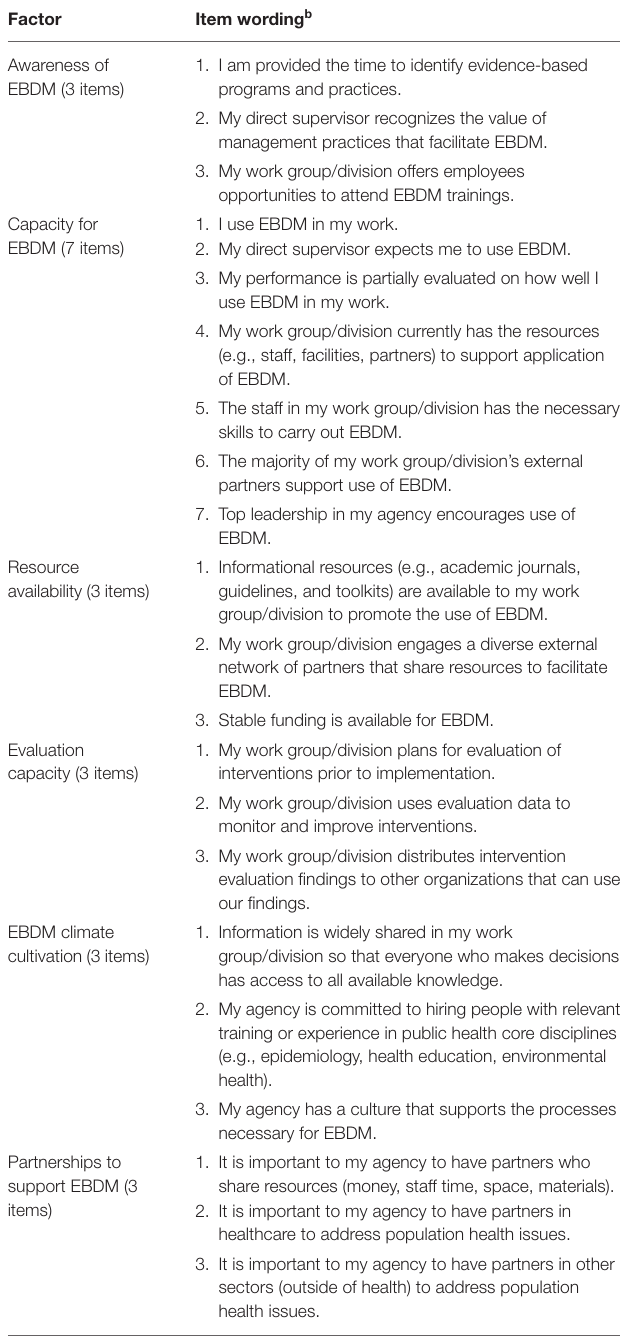
TABLE 1 | Evidence-based decision making (EBDM) support factors and items a